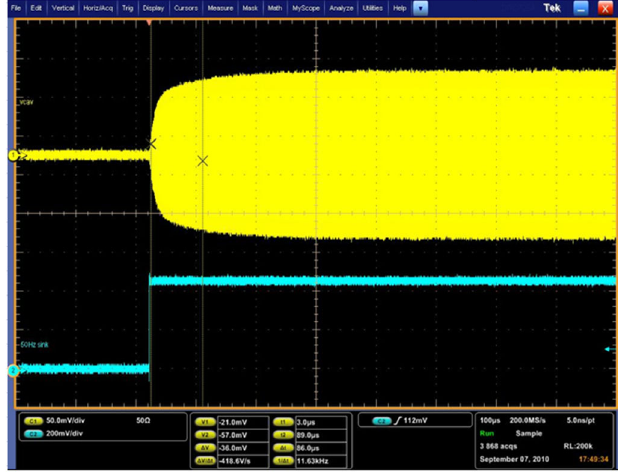
FIG. 20. Measured RFQ voltage in pulsed mode; the settling time ( 100 (cid:2) s approximately) can be further reduced by a read- justment of the PI gains and/or feed-forward